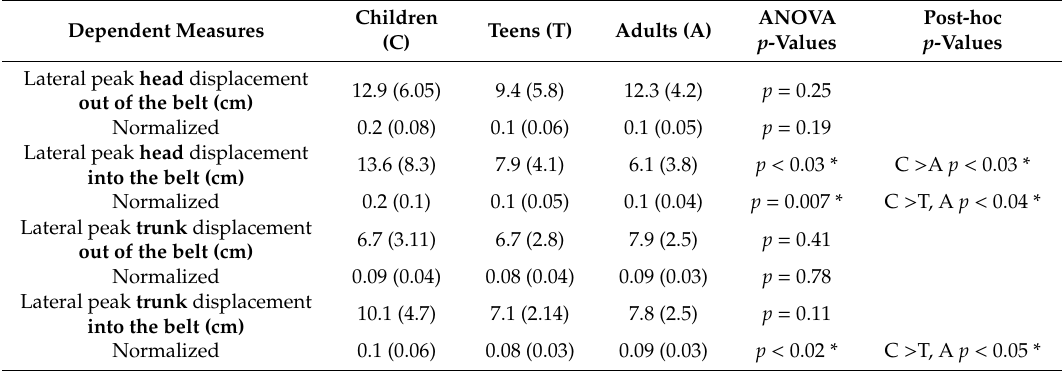
Table 2. Mean (SD) of normalized and non-normalized kinematic outcome measures: e ff ect of